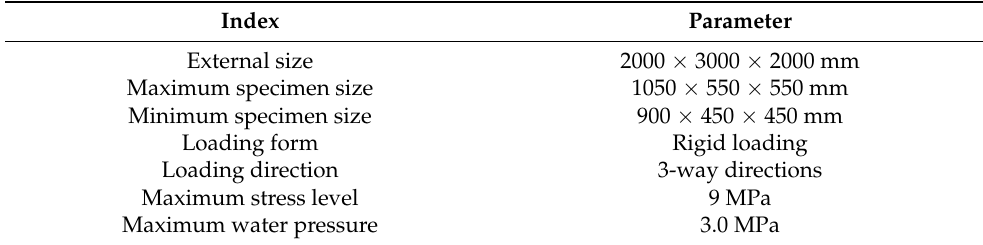
Table 1. Summary of specific instrumental parameters of the existing test apparatus.